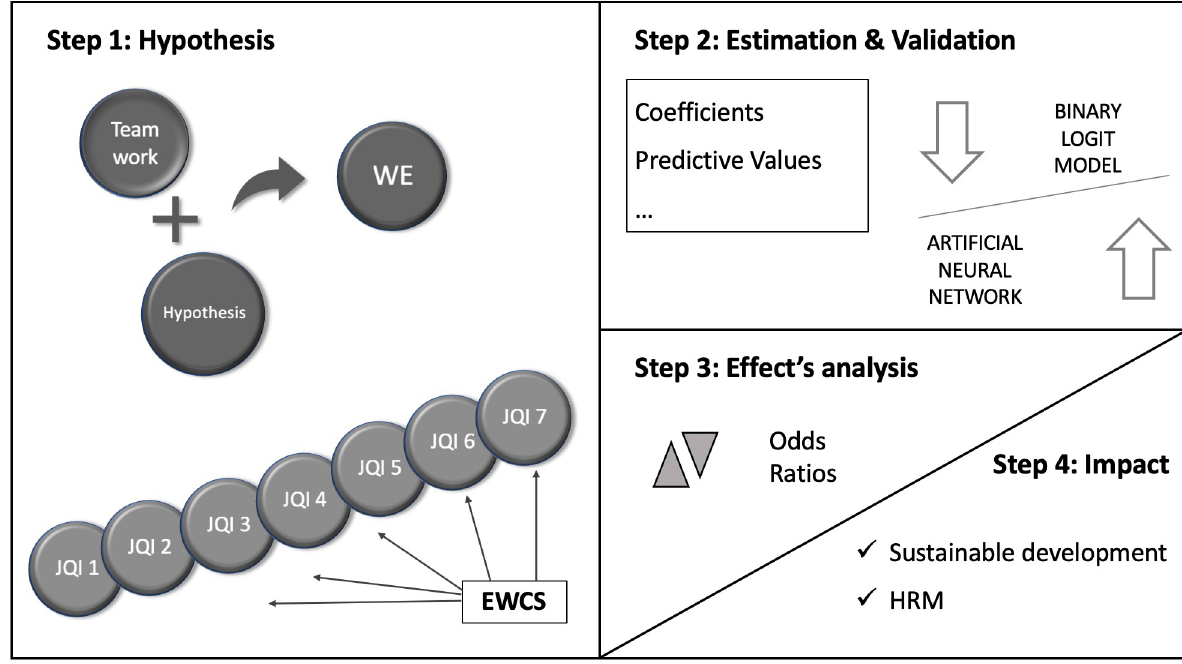
Fig 3. Phases of the research